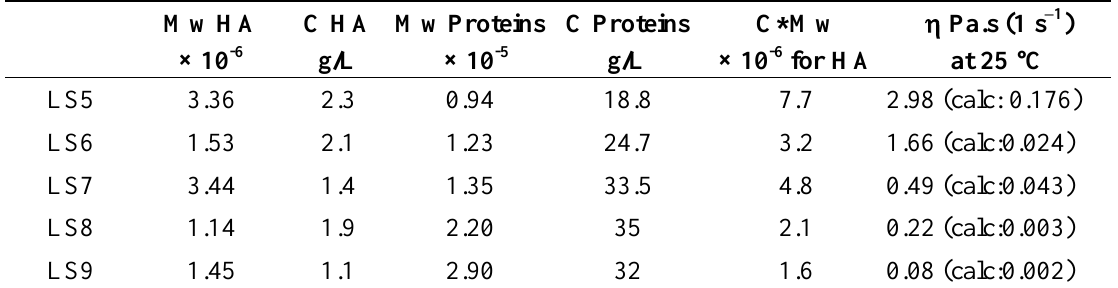
Table 3. Characteristics of different synovial fluids obtained by SEC analysis and viscometry at 25 °C.Comparison with calculated viscosity values.